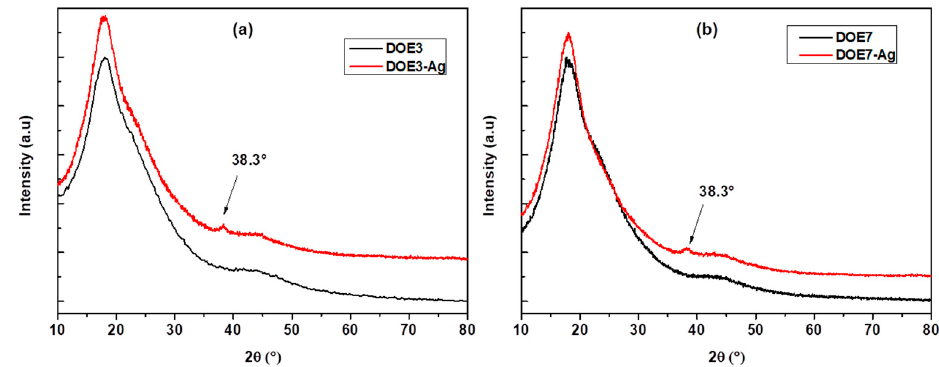
Figure 9. X-ray diffraction patterns of ( a ) DOE3 and DOE3-Ag, ( b ) DOE7 and DOE7-Ag. The results reported above indicate that the proposed coating processing, as opti- mized in our studies, can be considered substantially mild and potentially applicable on a wide range of soft materials in engineering. 3.3. Contact Angle Measurements From a functional standpoint, the application of the Ag nanocoating was proven to modulate the hydrophobicity of the substrate membrane based on the effects on contact angles measured in wettability tests. From the data shown in Figure 10, it clearly emerges that the Ag coating influences the wetting behaviour of water droplets on the PSU electrospun substrates, leading to an increased hydrophobicity, in accordance with our previous findings [18,29]. This effect is more pronounced in sample DOE3, where the contact angle is found to increase from about 112° for the uncoated PSU to about 142° for the Ag-coated PSU surface. The lower contact angle observed in sample DOE3, as compared to DOE7, could be attributed to the lower roughness of the sample surface [31], since the spread of a liquid droplet on a smooth surface is facilitated with respect to a rough surface where air can be trapped be- low the droplet and hinder its spread. Figure 10. Water contact angle values (WCA) (mean ± standard deviation) on PSU and PSU-Ag substrates. 3.4. Antibacterial Tests The antibacterial activity of the uncoated and Ag-coated PSU samples was deter- mined against the Gram-negative bacteria E. coli . The samples were incubated with the microbial population, and the survival rate was determined at 1, 2, and 3 h using the count plate method and calculation of CFUs/mL to determine the antibacterial action of the sam- ples. Figure 11 shows photographs of the Petri dishes obtained from control culture ( E.